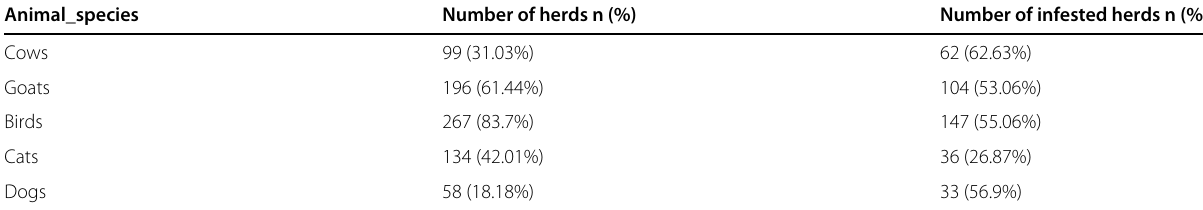
Table 2 Number of herds examined and infested by Tunga sp. Examinations were performed visually by lay staff members with assistance of household